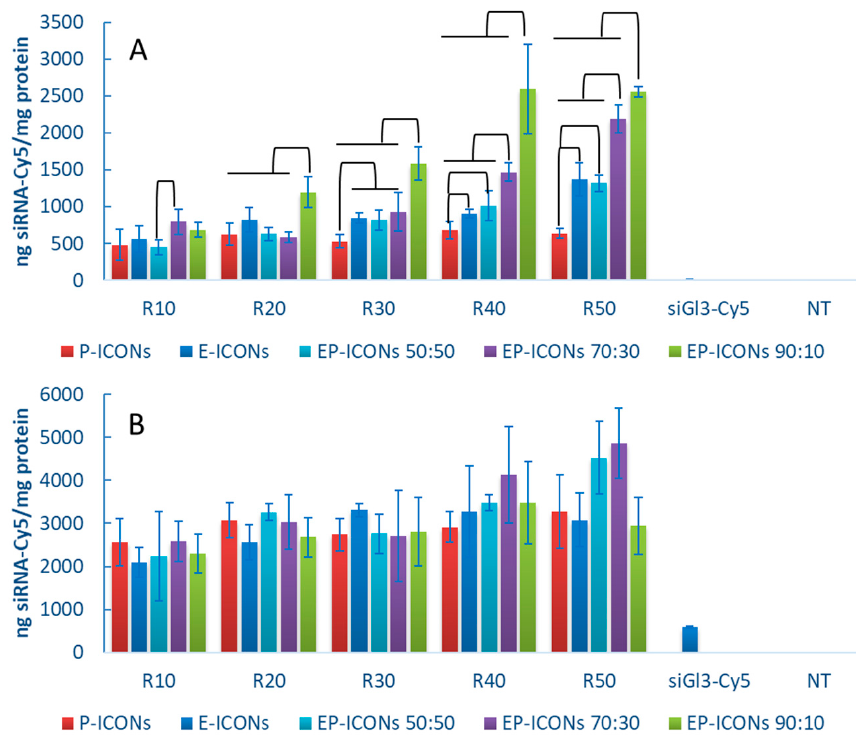
Figure 5. Quantitative uptake of siGL3-Cy5 in MCF-7 cells after 4 h ( A ) and 24 h ( B ) incubation with EP-ICONs at copolymer:siRNA weight ratios (R) comprised between 10 and 50. Results were compared with each other and with P-ICONs, E-ICONs, naked siRNA (siGL3-Cy5) and untreated cells (NT). Connections represent statistical differences with p < 0.05.